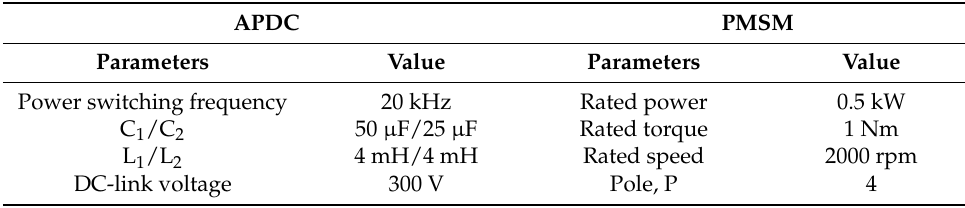
Table 1. Key parameters of the ECL motor